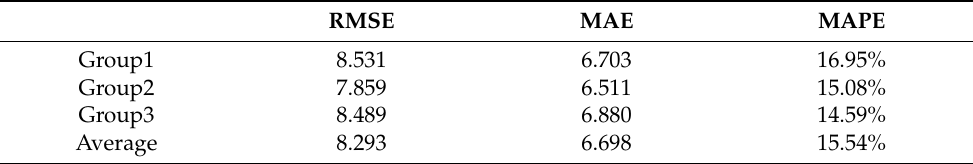
Table 7. Random forest fitting degree under the training set.